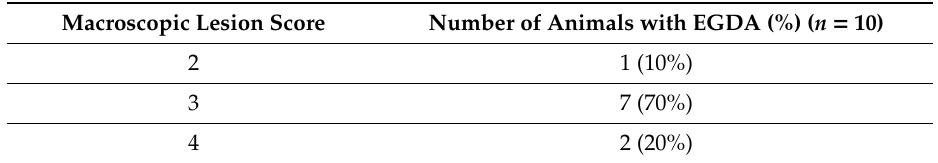
Table 2. Incidence of the particular macroscopic lesion score in esophageal mucosa of rats 10 weeks after esophagogastroduodenal anastomosis (EGDA)-inducing surgery.